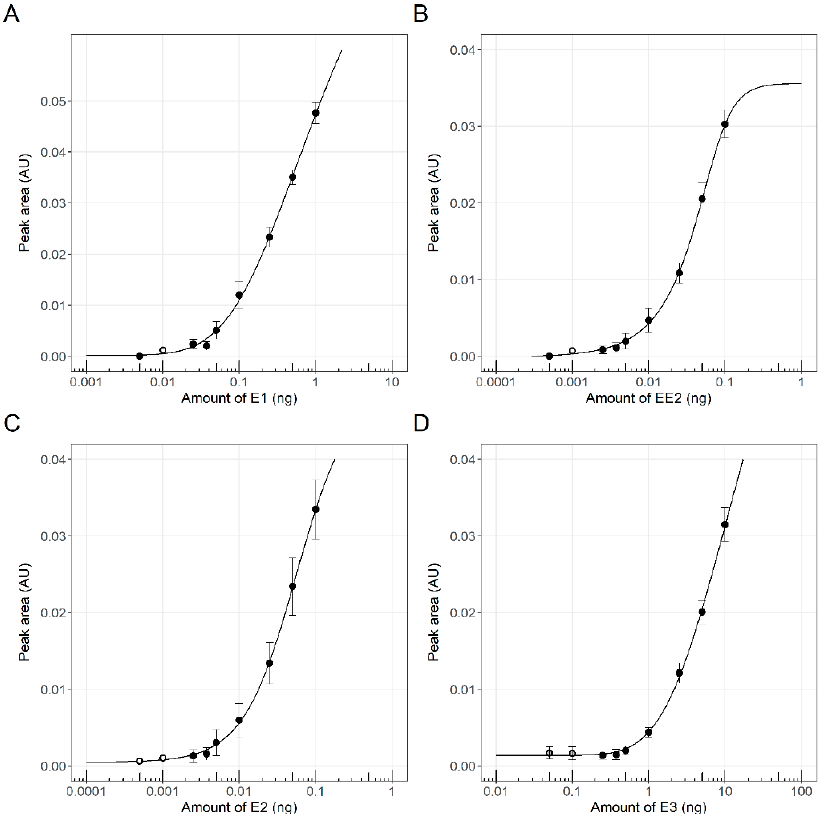
Figure 4. Dose-response curves of estrogenic reference compounds Estrone (E1, A ), 17 α -Ethinylestradiol (EE2, B ), 17 β -Estradiol (E2, C ), and Estriol (E3, D ), as derived from the experiment described in Figure 3 above. Fluorescent signal intensity determined by the peak area was plotted against the applied amount. Data points represent the mean values of the signal and the error bars show the respective standard error (n black = 3, n grey = 2 and n white = 1). The solid lines were fitted to the data using a five-parameter log-logistic function.